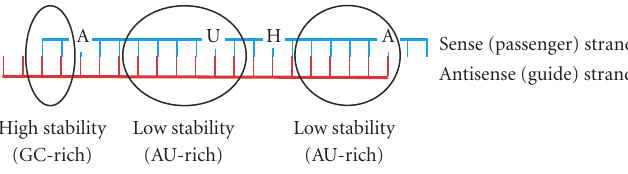
Figure 1: Features of e ffi cient siRNAs according to Reynolds et al [20]. The relative stability of both ends of the siRNA as well as the bases in certain positions influences the activity of siRNAs (H = A, C or U).